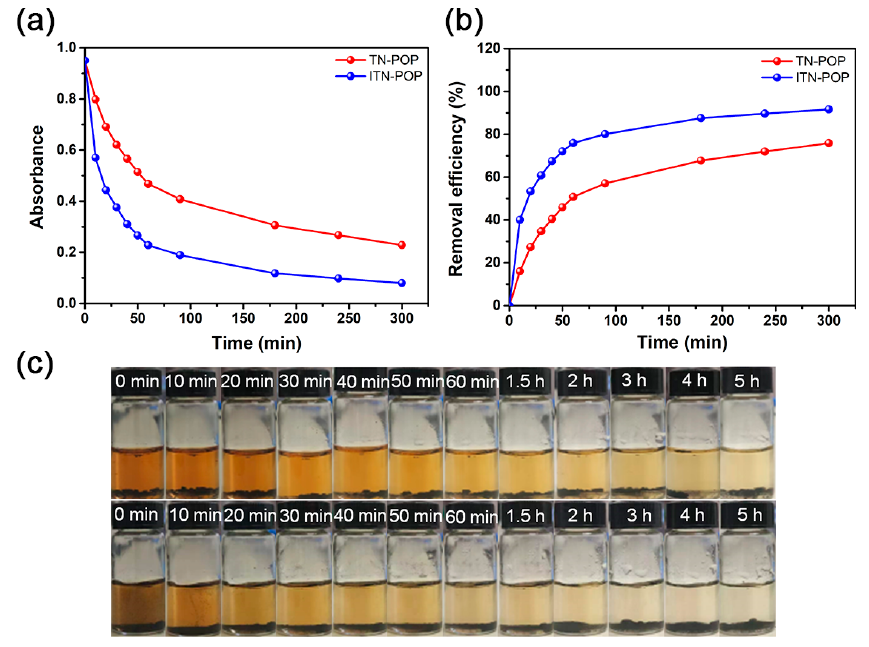
Figure 6. ( a ) The adsorption drops at 461 nm for ITN-POP and TN-POP containing iodine aqueous solutions; ( b ) Time-dependent adsorption profiles for ITN-POP and TN-POP in iodine saturated aqueous solutions (1.14 mM); ( c ) Photographs showing the color change for iodine aqueous solutions containing TN-POP (above) and ITN-POP (below).